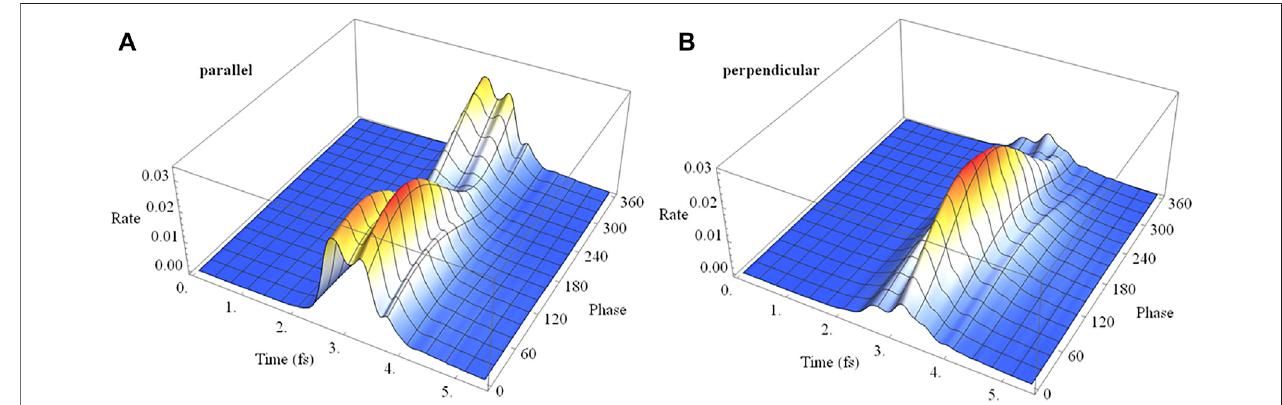
FIGURE14| Ionizationrateasafunctionoftimeandtheinitialphaseofthesuperposition(X+e i ϕ A)for2cyclecircularlypolarized800 nmpulsewith E max =0.0530 au with the carrier envelope maximum (A) parallel and (B) perpendicular to the molecular axis.